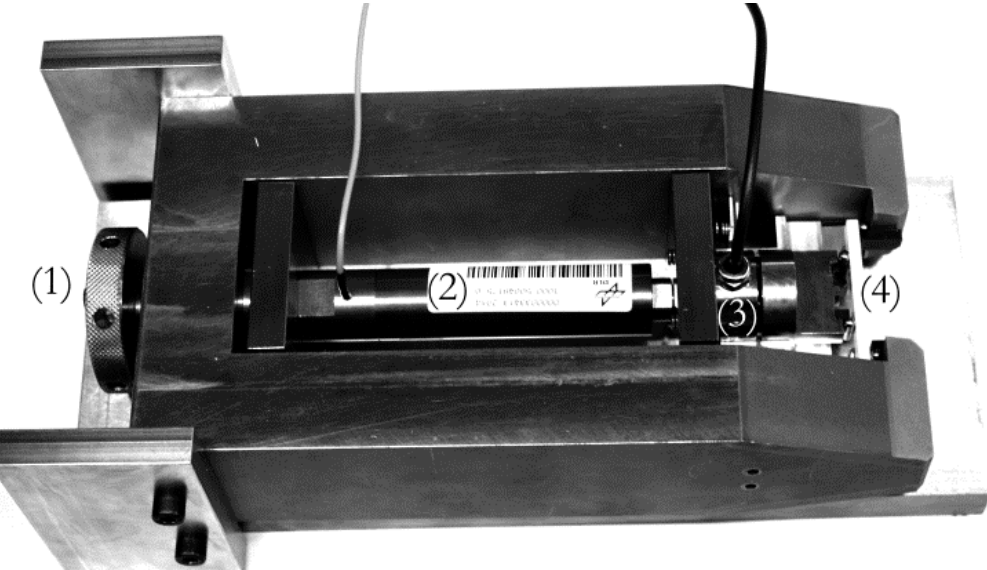
Figure 3. Piezo bending device with preload spindle ( 1 ), piezo actuator ( 2 ), load cell ( 3 ) and bending bar ( 4 ) between the four rollers.